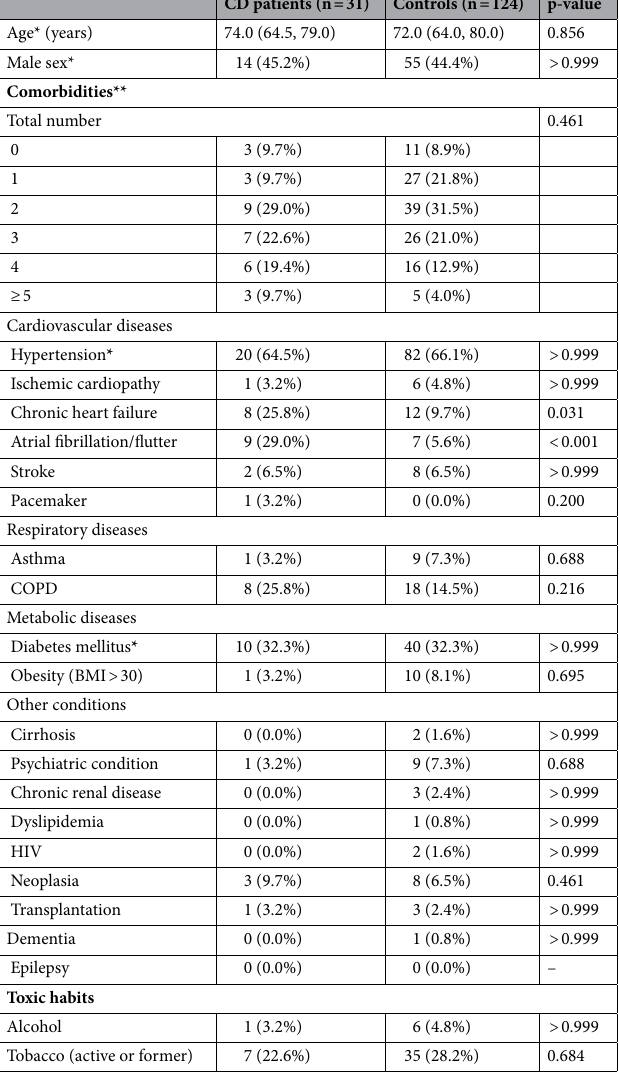
Table 1. Demographic characteristics and medical history data of the study population at baseline. Numbers are presented are medians (P25-P75) or counts (percentages). BMI body mass index, CD Chagas disease, COPD chronic obstructive pulmonary disease. *Controls were paired for age, sex, hospital, hypertension and diabetes. **This variable does not include Chagas